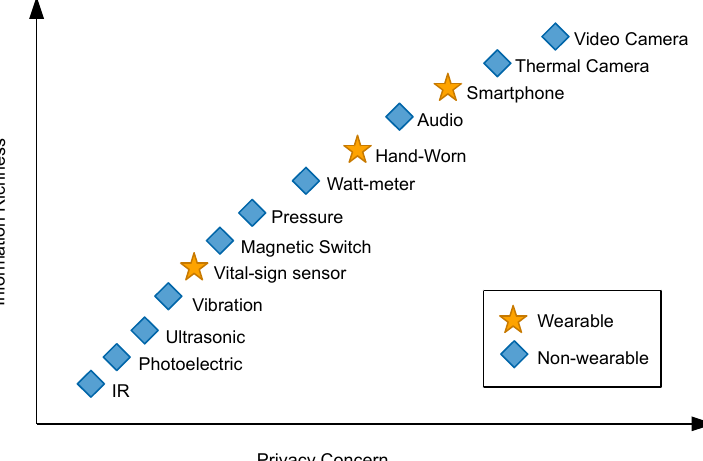
Figure 2 . The richness of the sensors versus privacy concern [33]. Figure 2. The richness of the sensors versus privacy concern